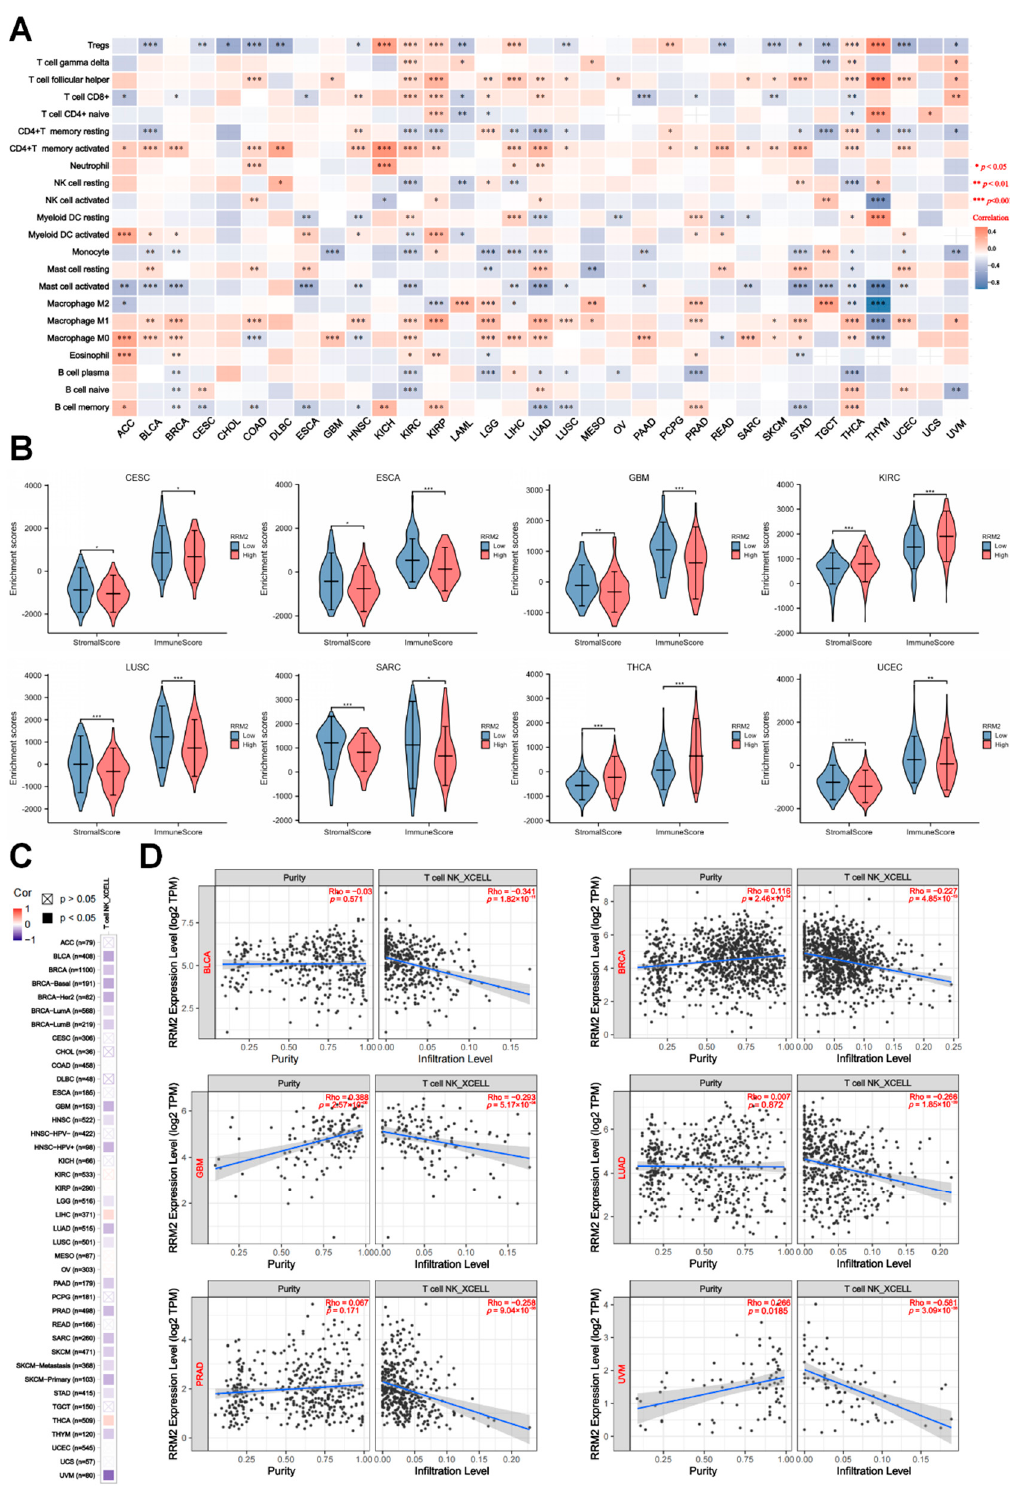
Figure 7. Correlation between RRM2 and immune infiltration in pan-cancer. ( A ) Correlations between RRM2 expression level and immune cells in pan-cancer. ( B ) Correlation between RRM2 expression and immune and stromal scores in multiple cancers. ( C , D ) Correlations between RRM2 expression level and the infiltration level of NK T cells across TCGA cancers. Heatmap ( C ) and scatter plots ( D ) of NK T cells infiltration level related to RRM2 expression were presented, utilizing the TIMER2.0 database. (* p < 0.05, ** p < 0.01, *** p < 0.001.)